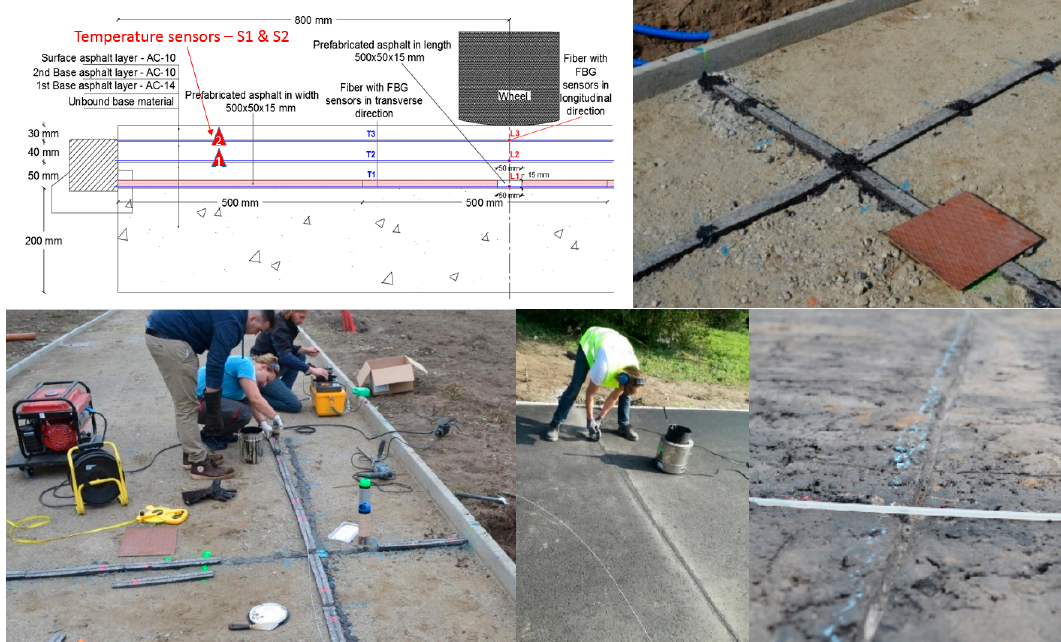
Figure 8. UAntwerp FBG monitoring system sensors configuration in the three asphalt layers with sensors embedded in prefab specimens and grooves at CyPaTs bicycle path